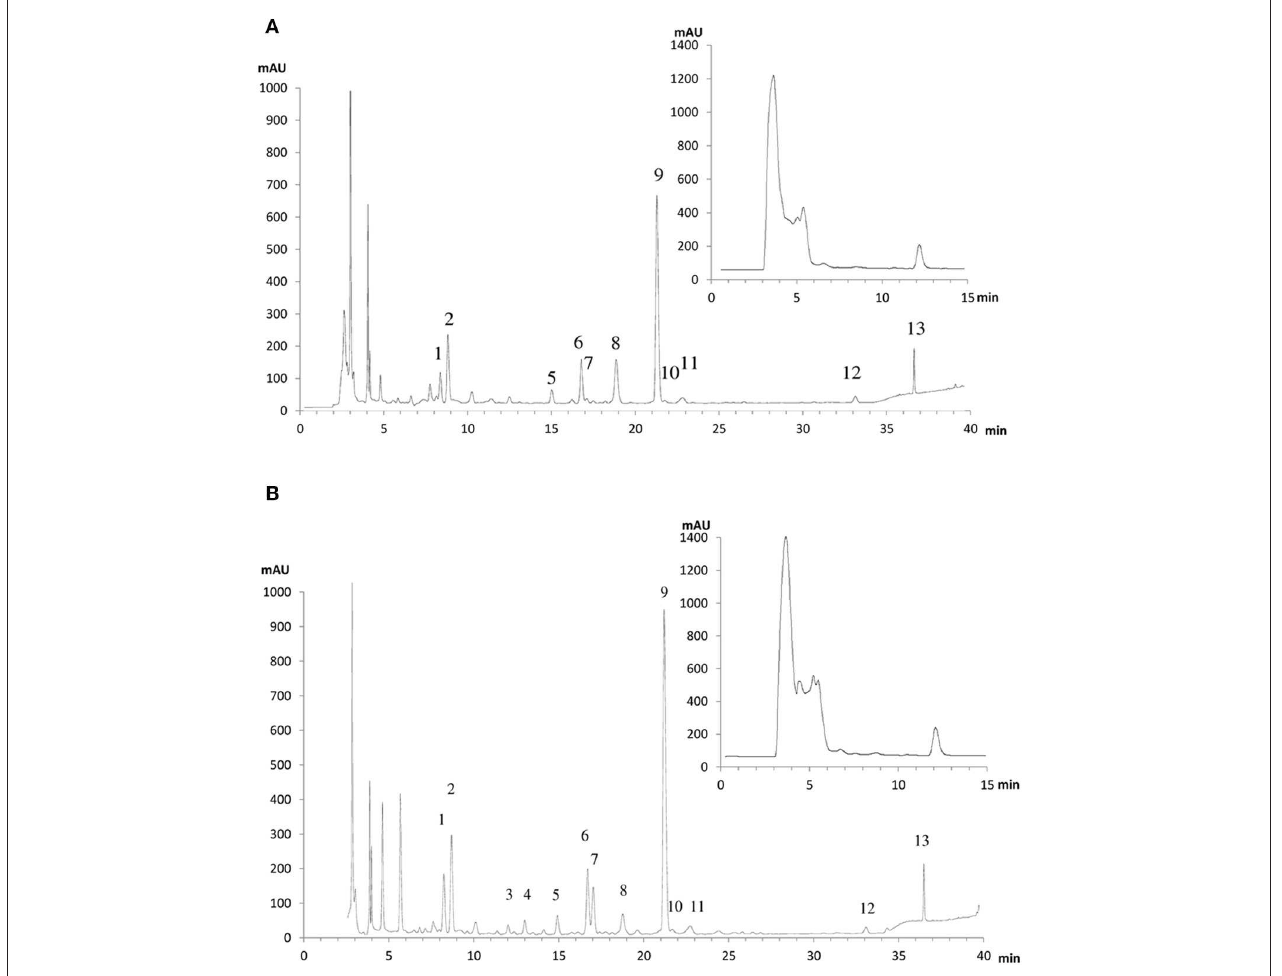
FIGURE 4 | HPLC elution profiles of flavonoids and isoflavonoidsfrom L. japonicus leaves of (A) WT plants under normal watering conditions and (B) WT plants under drought stress conditions. A typical chromatographic profile for 50% methanol leaf extracts from WT plants grown under either control conditions or drought stress conditions is presented. The compounds were detected according to their absorbance at 280nm. The peak numbers correspond to the metabolites: 1: kaempferol-3-O-glucosyl (1-2)-glucoside-7-O-rhamnoside; 2: kaempferol-3-O-glucosyl (1-2)-galactoside-7-O-rhamnoside; 3: quercetin 6-deoxyhexose-hexose; 4: quercetin 6-deoxyhexose-hexose; 5: kaempferol-3-O-galactosyl-7-O-rhamnoside; 6: kaempferol-3-O-glucosyl-7-O-rhamnoside; 7: quercetin 6-deoxyhexose-6-deoxyhexose; 8: p-coumaric acid; 9: kaempferol-3,7-di-O-rhamnoside; 10: p-ferulic acid; 11: simple phenylpropanoid; 12: kaempferol-6-deoxyhexose; 13: flavonol-6-deoxyhexose. The chromatograms shown here are for only one of the six different biological replicates used in this work. For the relative quantification of metabolite levels presented in Table 5 the mean of all the six replicates was used. In the inset is the chromatographic profile for the 100% methanol leaf extracts, where the peak corresponding to vestitol can be seen, eluting at min